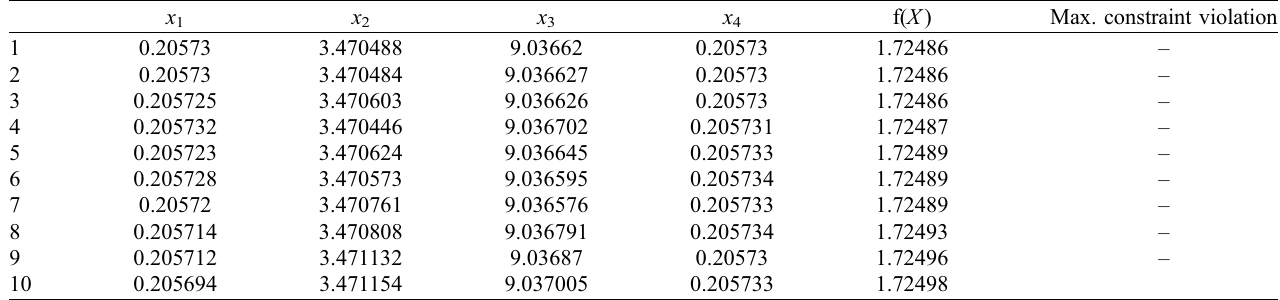
Table 7. Top ten optimum solution obtained for example 1 using ABC. x 1 x 2